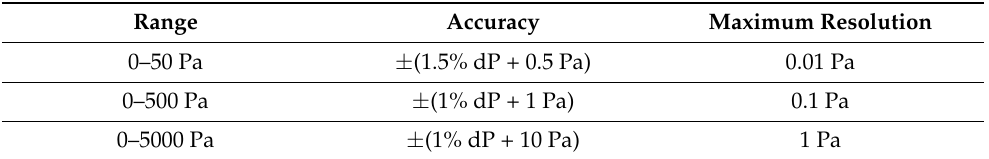
Table 5. Ranges of the device for measuring the pressure drop Δ P where dP is the measured value of the pressure drop, with permission from Ref [31], 2022, ATEQ.